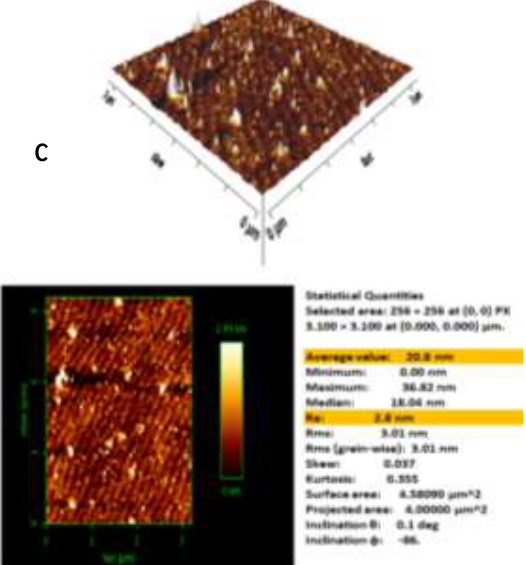
Figure 4: AFM image of Al 2 O 3 NPS at different energy (A) 500, (B) 800, and (C) 1000) mJ.